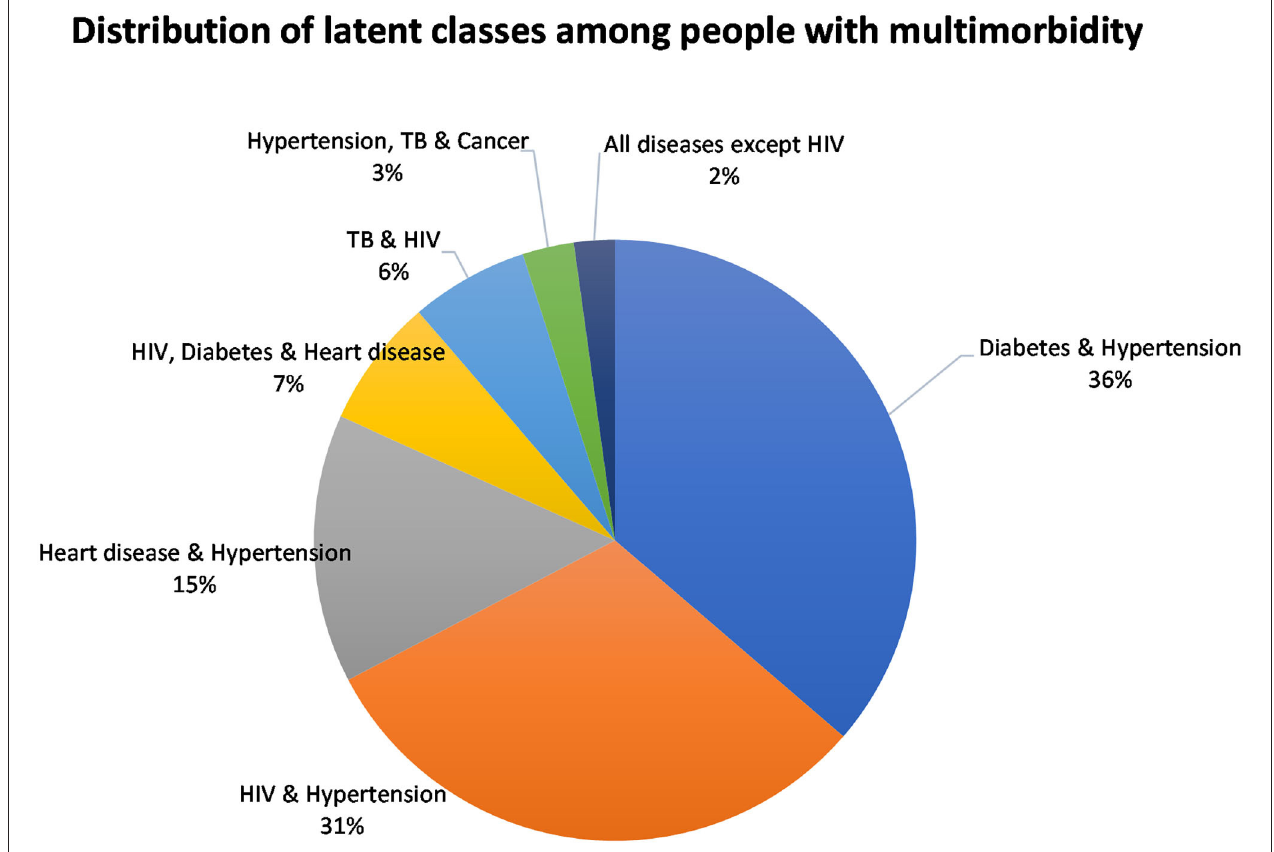
FIGURE 3 | Distribution of latent class membership for people with multimorbidity.